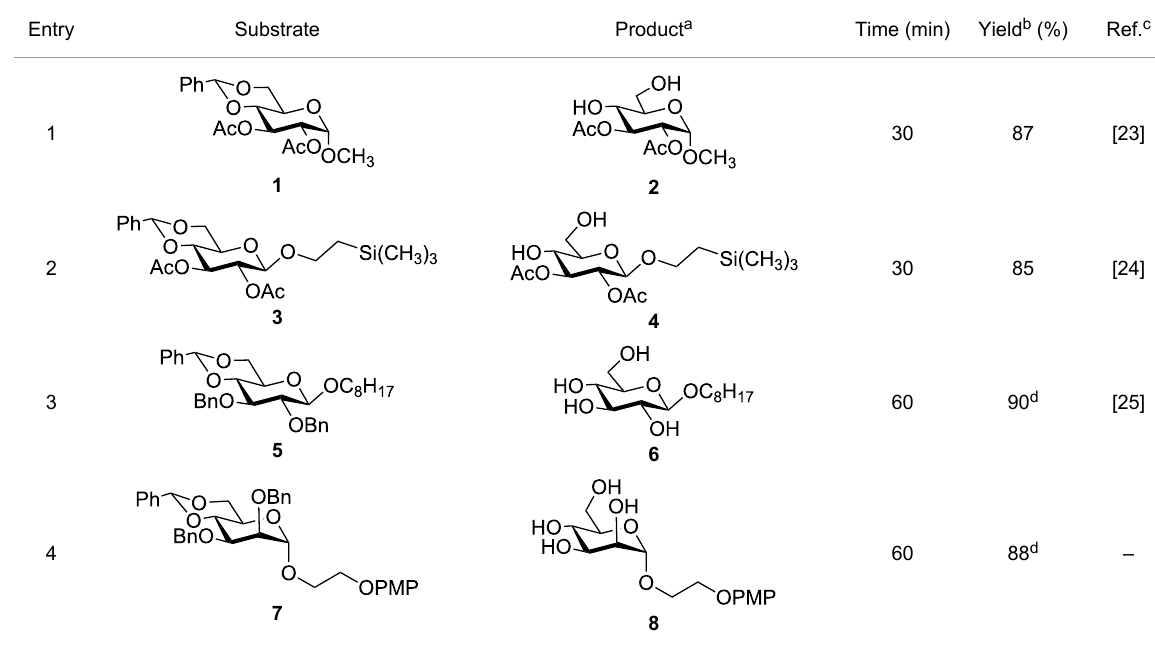
Table 1: Conversions of carbohydrate derivatives effected with Et 3 SiH and 10% Pd/C.